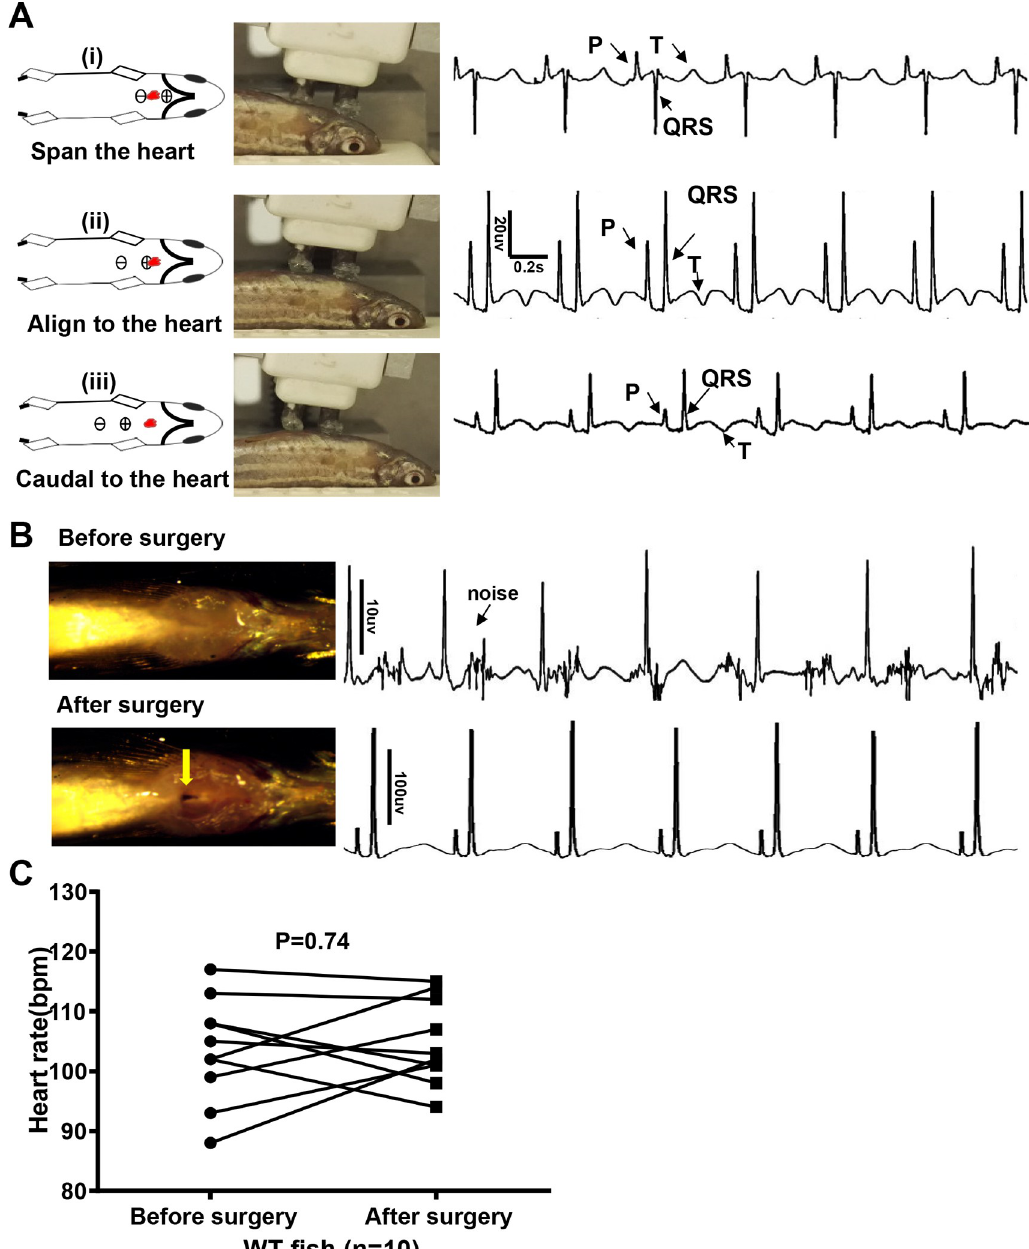
Fig 1. Quality of electrocardiography (ECG) signals is improved by optimizing location of the probes and microsurgery. A, Different ECG waveform with distinct P, R, S, and T waves when probes were at a different location relative to the heart (red dots). We recommend aligning the positive probe to the heart (ii), whereby the ECG waveform is similar to that in humans. B, Microsurgery was conducted to open the pericardium sac and thus eliminate noise and enhance amplitude of the waveforms by about 10-fold. C, Change in heart rate with surgery. bpm indicates beats per minute; WT, wild-type.